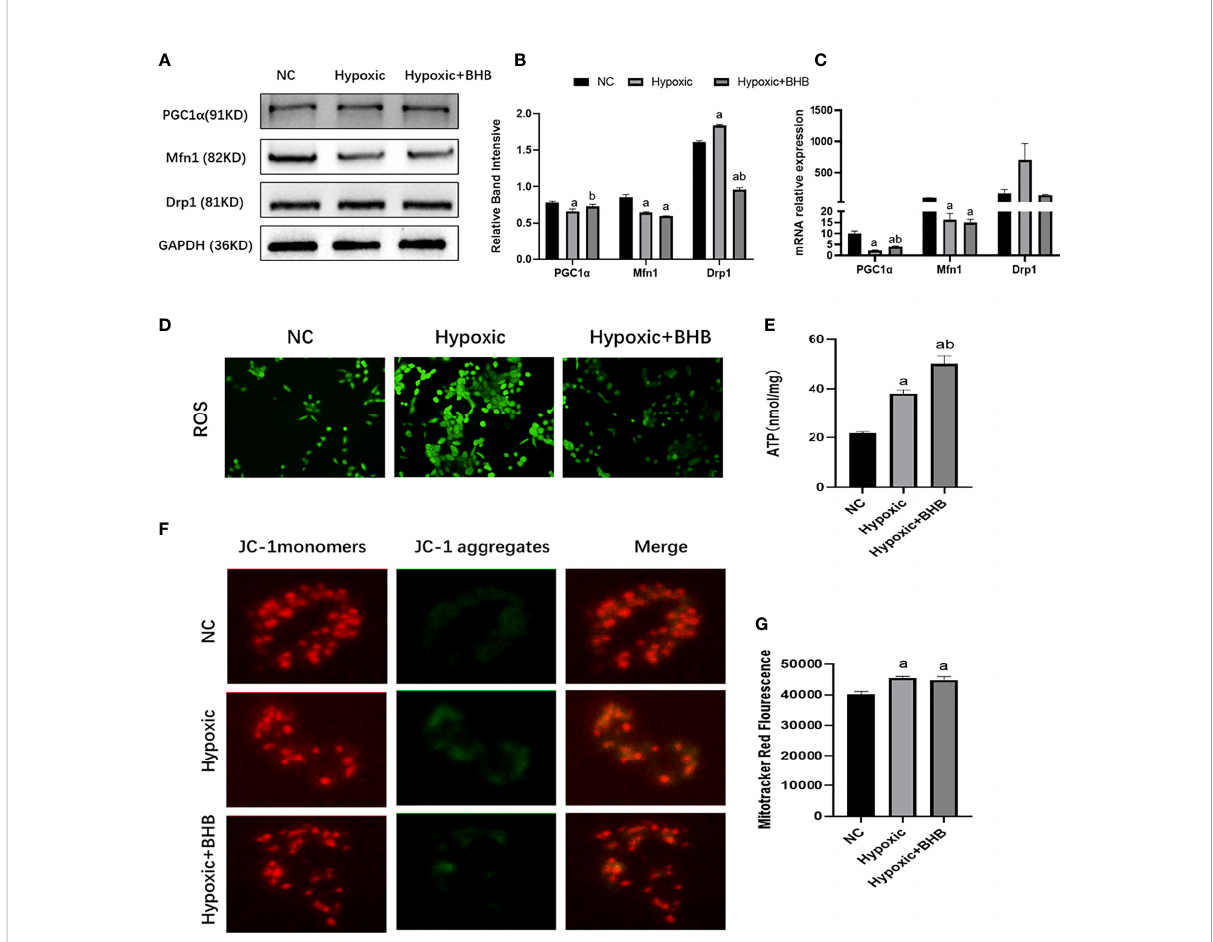
FIGURE 5 Effect of BHB supplement on the mitochondrial function in HK2 cells under hypoxic condition. (A – C) Expression of PGC1 a , Mfn1, and Drp1 in HK2 cells under hypoxic condition with or without 2 mmol/l BHB; (D – G) Changes of ROS, ATP production, mitochondrial membrane potential, and the mitochondrial number, respectively. a p < 0.05, compared with the NC group; b p < 0.05, compared with the Hypoxic